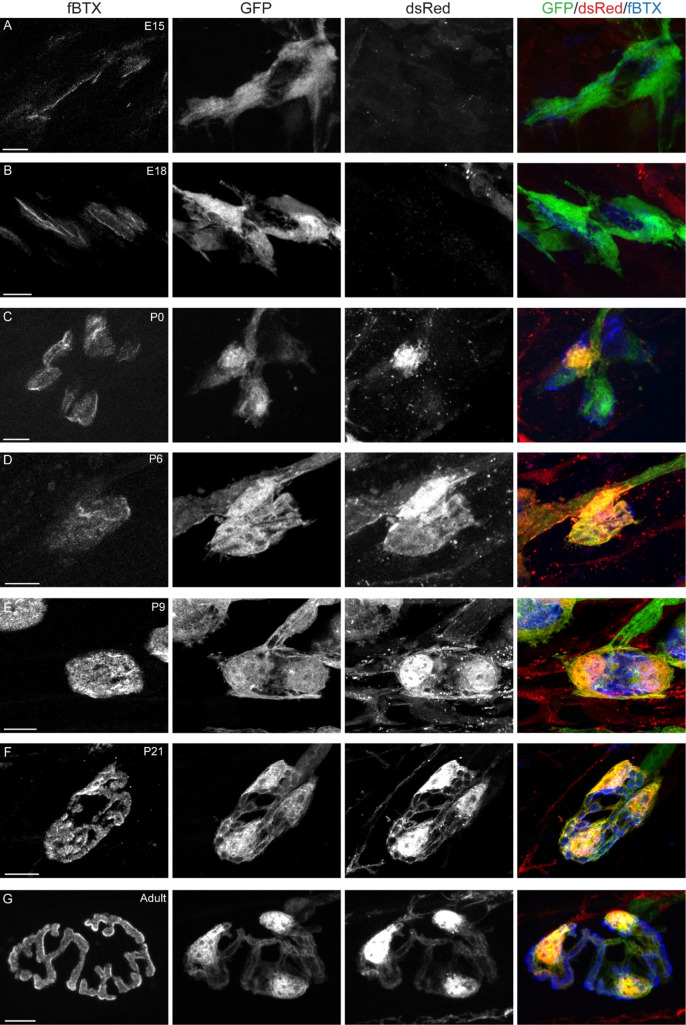
Color and grayscale images of PSCs in the EDL muscle of (A) E15, (B) E18, (C) P0, (D) P6, (E) P9, (F) P21, and (G) adult S100β-GFP;NG2-dsRed mice.Scale bar = 10 μm.